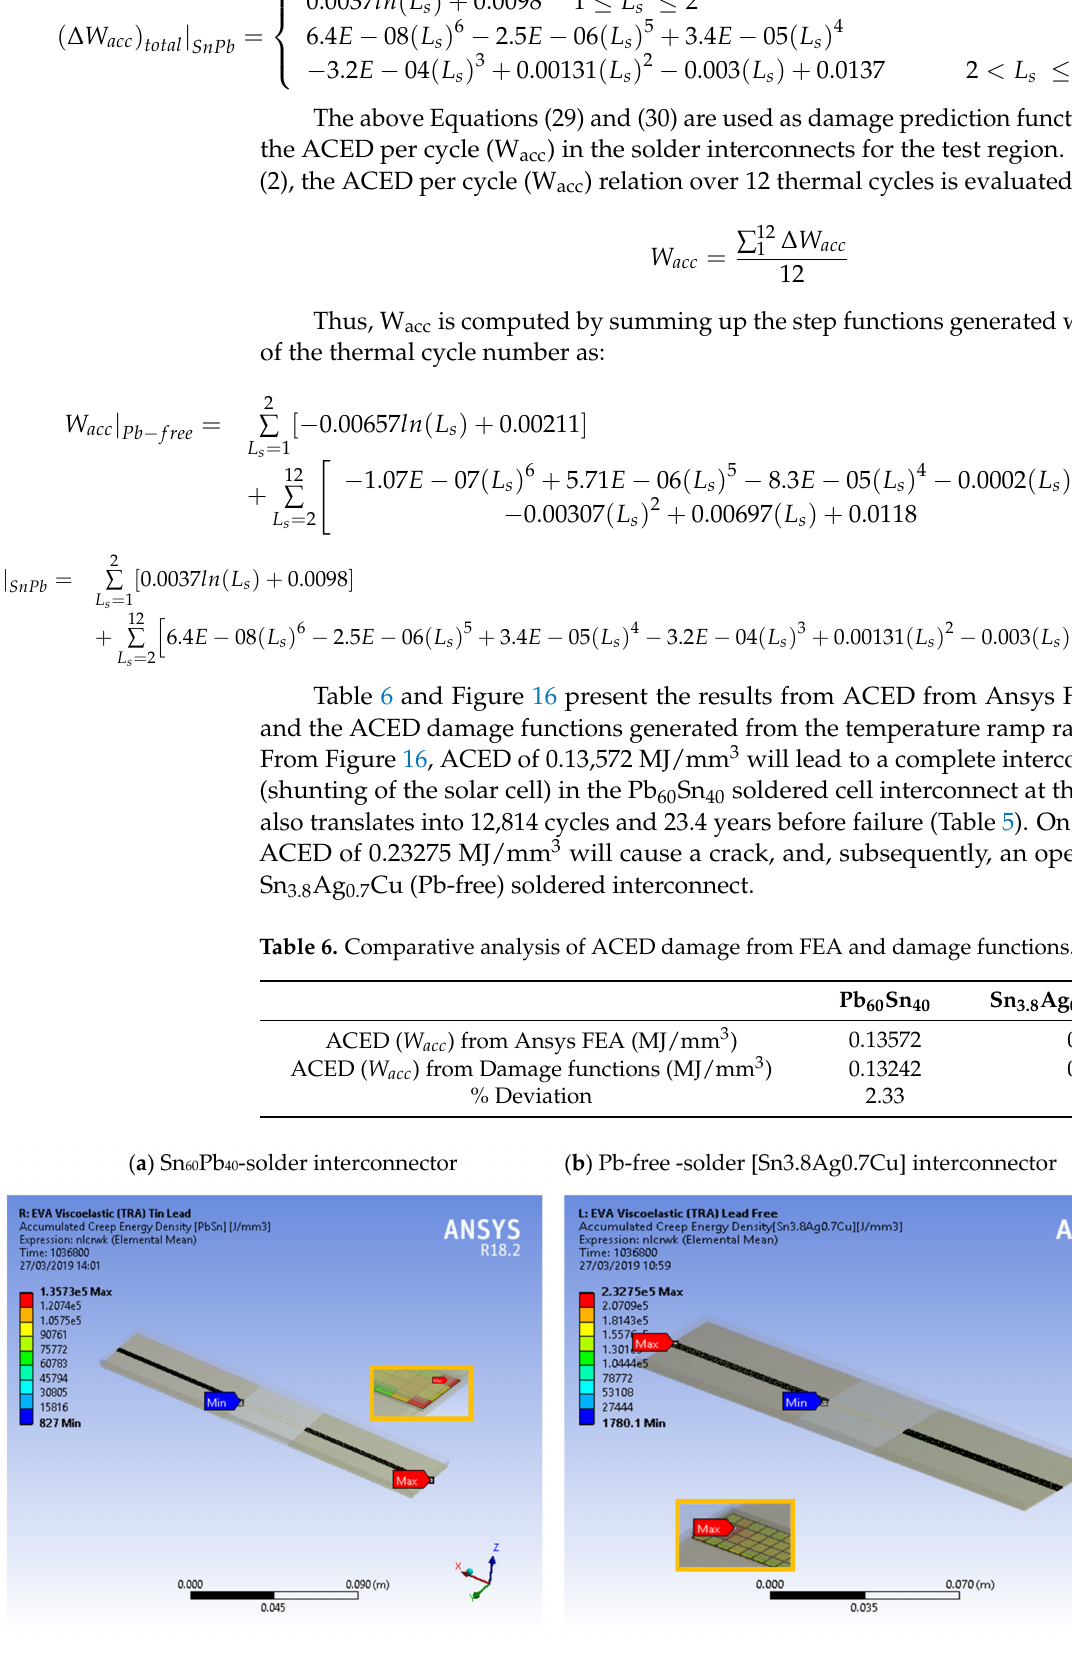
Figure 16. Accumulated creep energy density distribution at the end of 12 thermal cycles ( a ) Sn 60 Pb 40 , ( b ) Pb-free